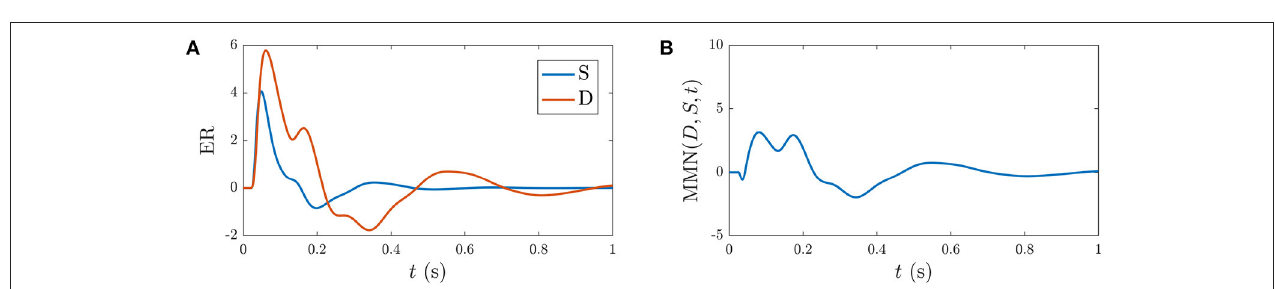
∞ response labeled. The horizontal axis indicates time and is labeled with stimulus types and numbers. The blue curve corresponds to stimuli S 1 , ... , S 5 and the orange